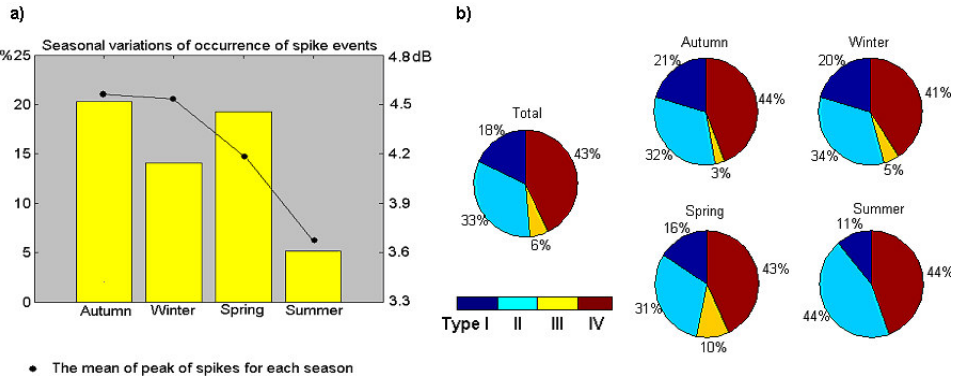
Fig. 3. (a) Seasonal variations of spike events in the IRIS FoV during 1994–2003. Bars are seasonal occurrence (event/day) of spike events and dots are the mean intensity of spikes for each season. (b) Total (left) and seasonal distribution of 4 types of spike events during